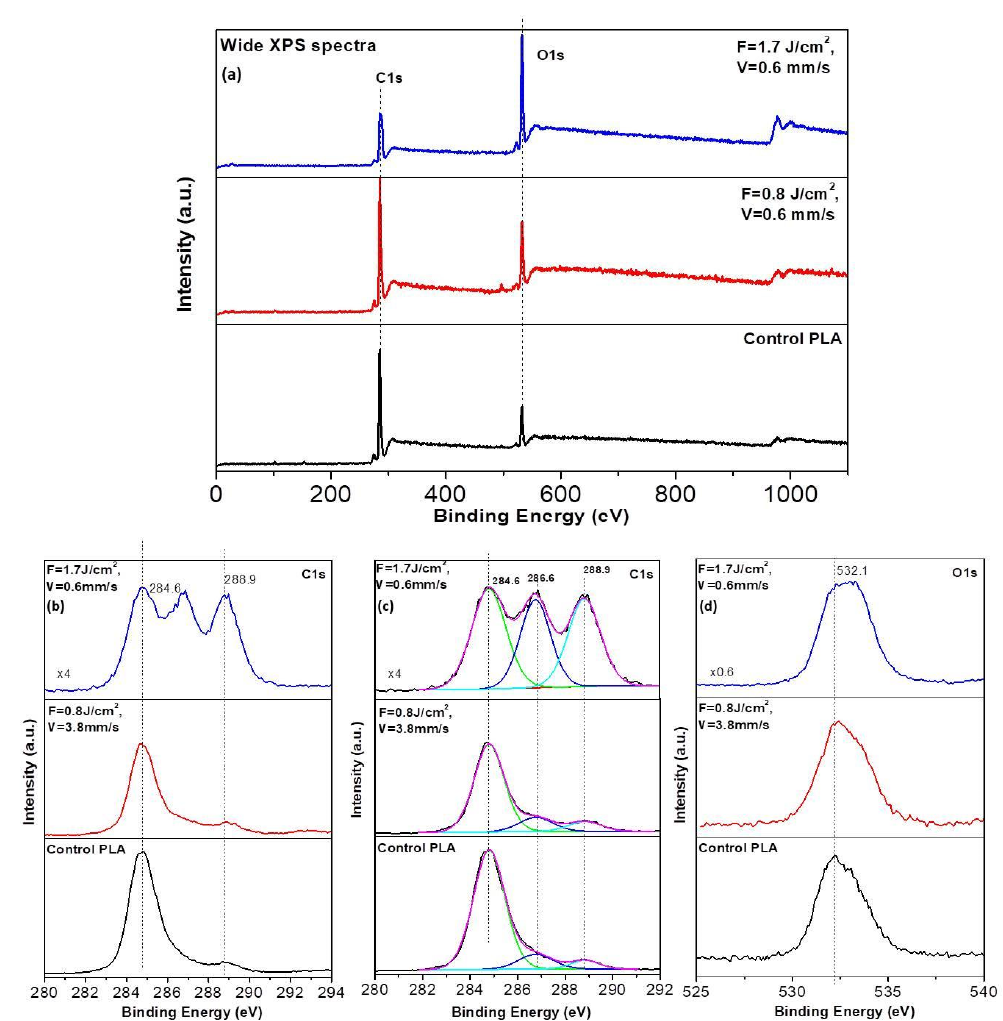
Figure 12. Comparison of XPS spectra of PLA surfaces treated by laser irradiation at F = 0.8 J/cm 2 , V = 3.8 mm/s and F = 1.7 J/cm 2 , V = 0.6 mm/s; ( a ) Wide XPS Spectra; ( b ) C 1s spectra; ( c ) C 1s decomposed spectra; ( d ) O 1s spectra. Table 3. pH change of PBS of Group1 (G1)—PLA F = 0.8 J/cm 2 , V = 3.8 mm/s; Group2 (G2)—PLA F = 1.7 J/cm 2 , V = 0.6 mm/s and Group3 (G3)—control PLA during the 8 week period of in vitro deg-